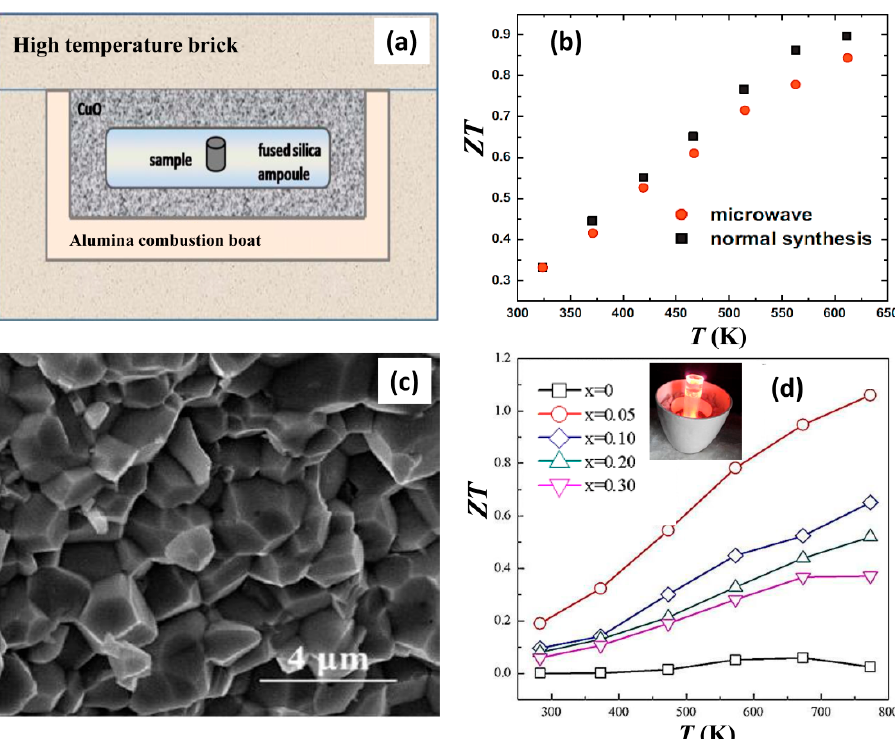
Figure 12. ( a ) Schematic of the setup used for the microwave synthesis of In 0.2 Co 4 Sb 12 material; ( b ) temperature dependence of the ZT of samples prepared with the normal method and microwave method [79]; ( c ) FESEM image of cross-section of CoSb 2.95 Te 0.05 sample prepared with the microwave method; ( d ) temperature dependence of ZT of CoSb 3 − x Te x samples [82].